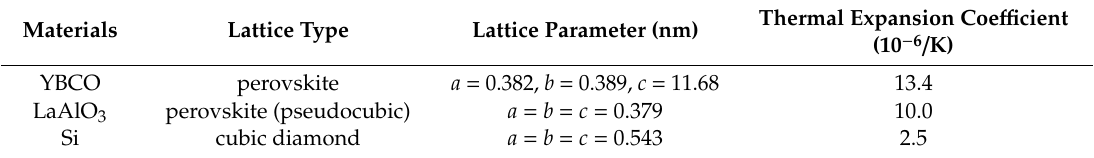
Table 1. Physical parameters of YBCO, LaAlO 3 and Si.